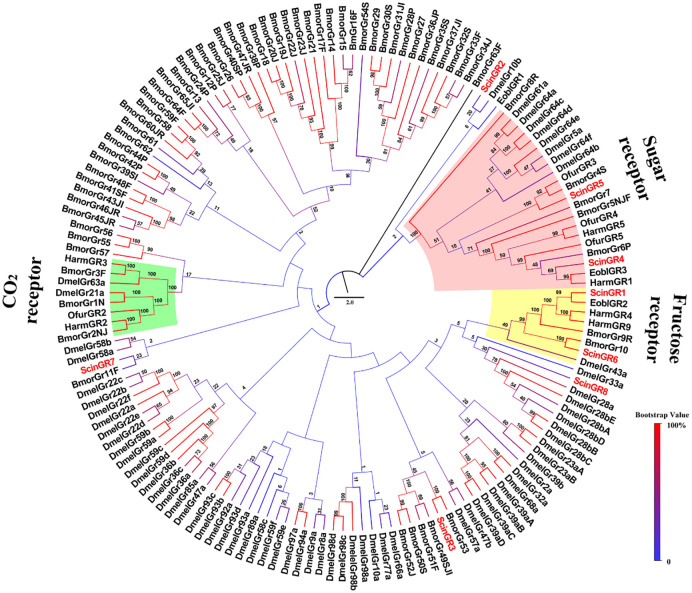
Phylogenetic tree of GR proteins in Semiothisa cinerearia, Ectropis obliqua, Bombyx mori, Ostrinia furnacalis, Helicoverpa armigera and Drosophila melanogaster.The sequences used in this analysis are listed in S8 Table.